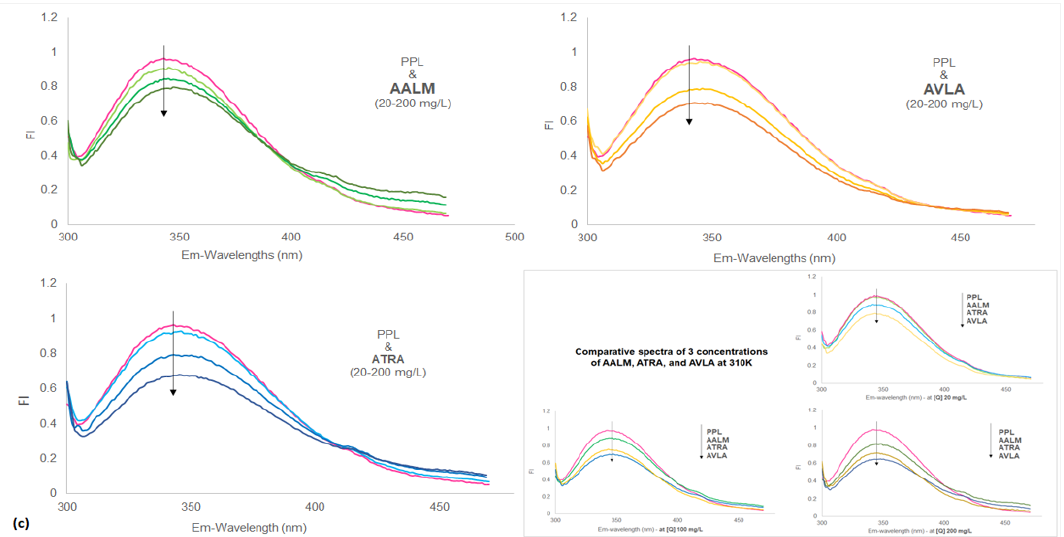
Figure 4. Fluorescence spectra of porcine pancreatic lipase (PPL) shows fluorescence quenching in the presence of extracts and compounds. Fluorescence intensities (FI) vs. wavelengths (λ nm) at different temperatures ( a ) 310; ( b ) 320; and ( c ) 330 K temperatures (PPL + extracts: 20, 100, and 200 mg/L); Insets show: PPL + orlistat: 1.0, 2.0, and 3.0 µ M/L ( a ), PPL + betahistine: 0.4, 0.6, and 0.8 µ M/L ( b ) and Comparative spectra of 3 concentrations of AALM, ATRA, and AVLA ( c ), at 310 K.